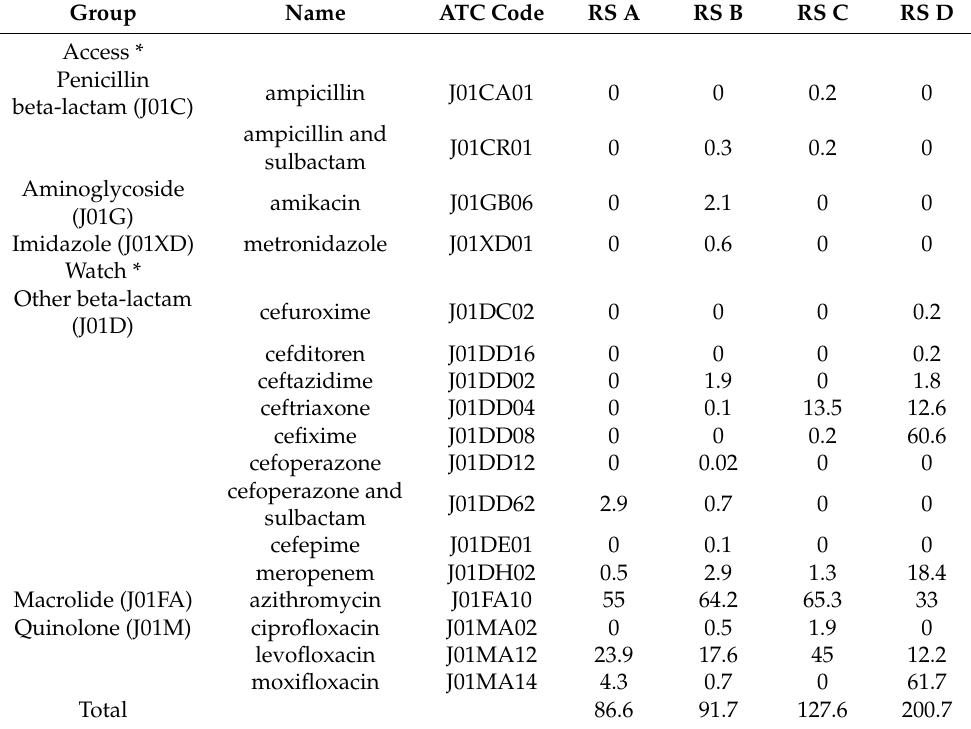
Table 2. DDD per 100 bed-days antibacterials.